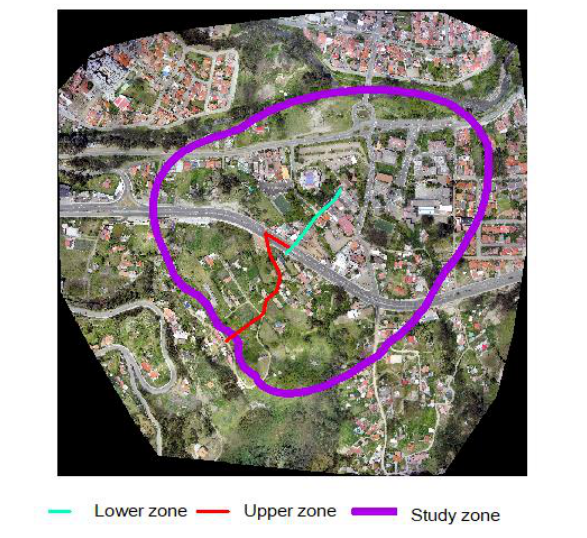
Figure 1. Study area, Cuenca - Ecuador. Distribution of scan